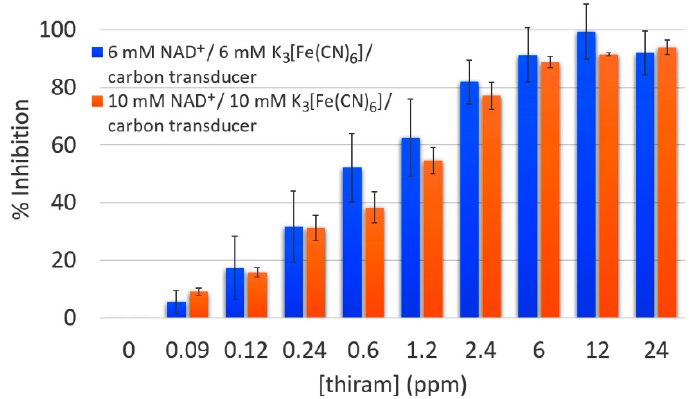
Figure 5. Detection of thiram at +0.20 V. Incubation was performed with various concentrations of thiram and 0.58 U/mL ALDH, 0.58 U/mL DP and 2 mM PPA in 0.1 M phosphate + 0.1 M KCl buffer solution pH 8.0. DRP-110 modified with 6 mM NAD + and 6 mM K 3 [Fe(CN) 6 ] (blue columns) and with 10 mM NAD + and 10 mM K 3 [Fe(CN) 6 ] (orange columns) were used as transducers. Different concentrations of NAD + and K 3 [Fe(CN) 6 ] (1, 3, 6, 10 and 15 mM)